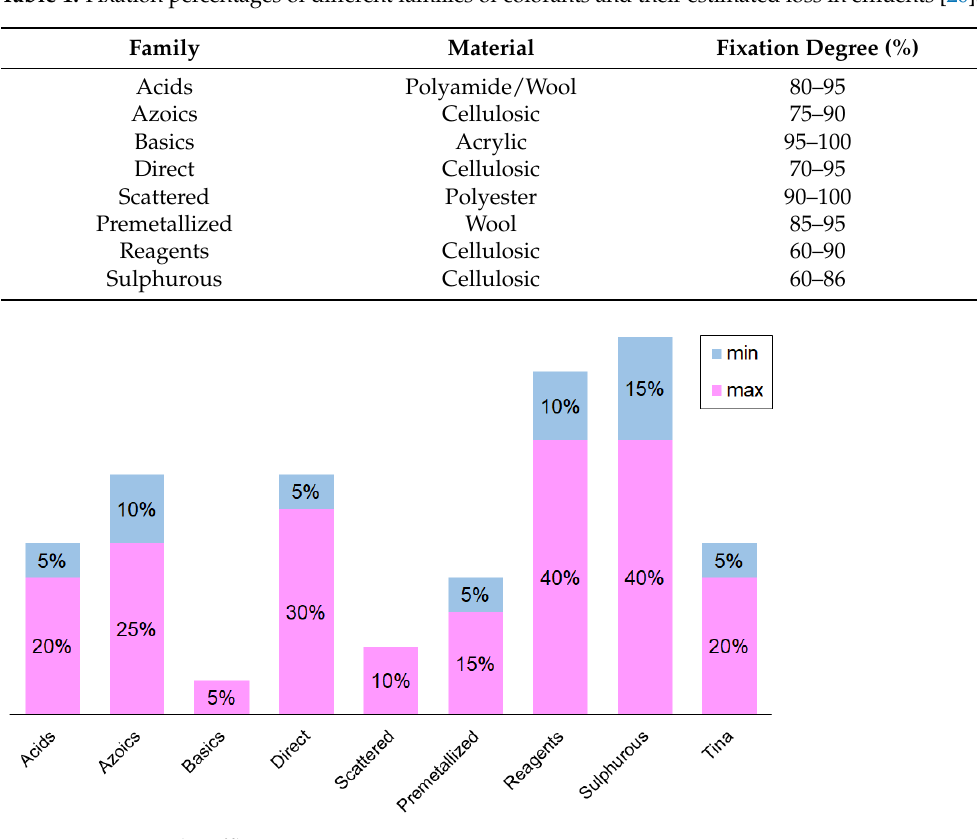
Table 1. Fixation percentages of different families of colorants and their estimated loss in effluents